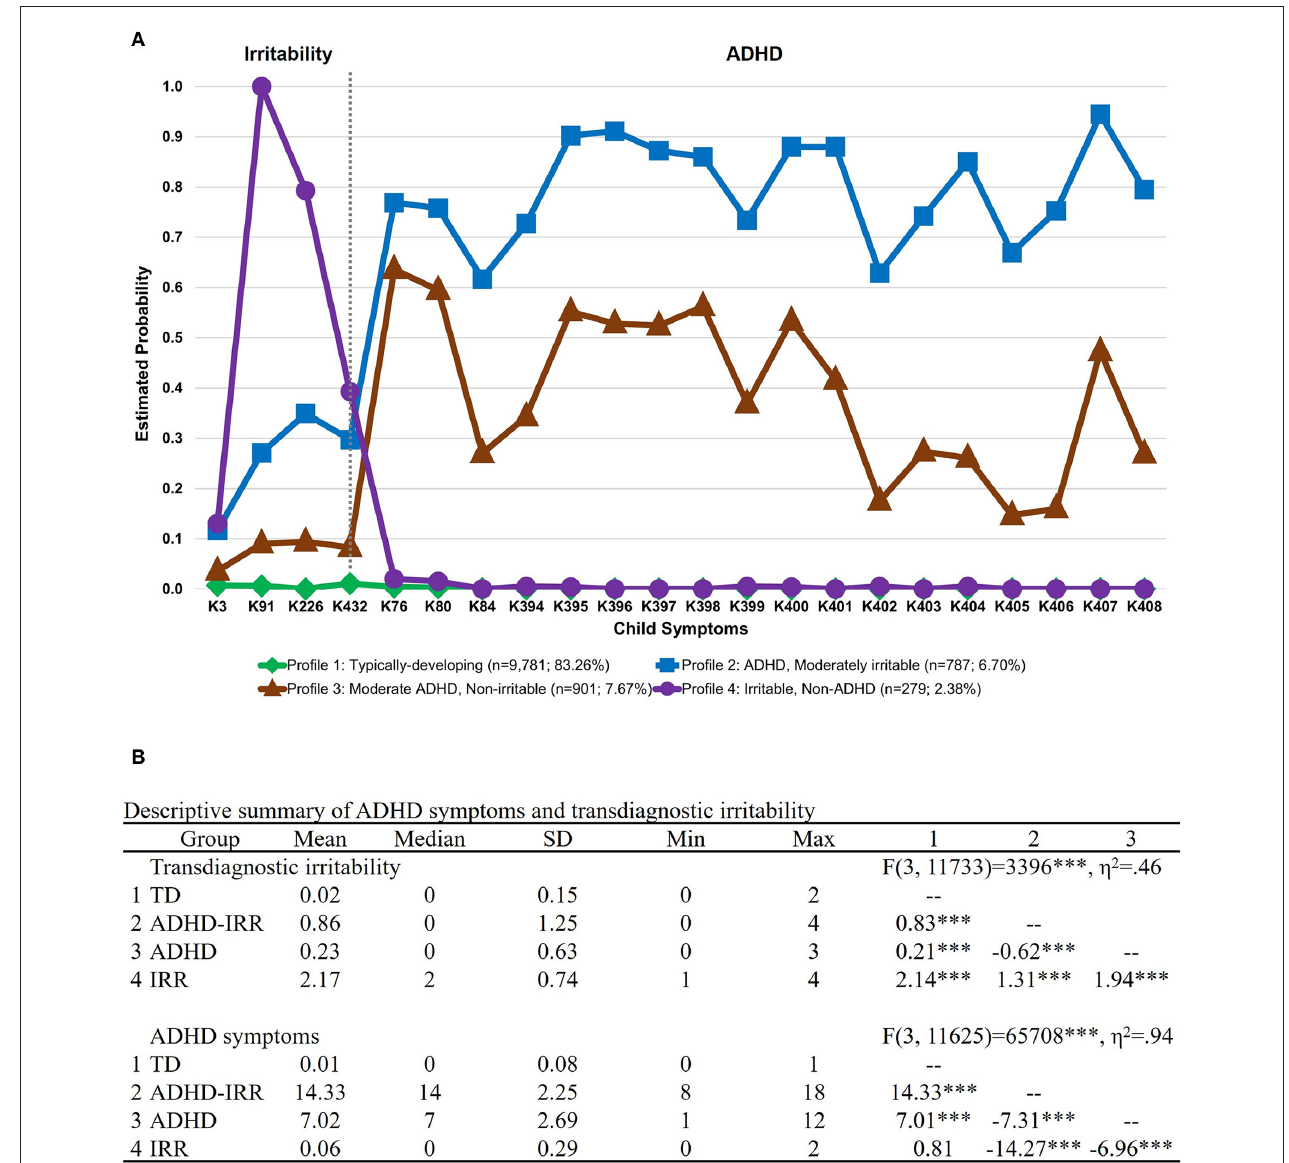
FIGURE 2 | Latent class membership based on ADHD symptoms and transdiagnostic irritability. Symptoms were derived from item-level symptoms assessed by the parent interview of the DSM-5 Kiddie Schedule for Affective Disorders and Schizophrenia (K-SADS). (A) Latent class graph visualizing the estimated probability of ADHD symptoms and transdiagnostic irritability for each group. (B) Descriptive summary of ADHD symptoms and transdiagnostic irritability for each latent class group based on item-level symptom count on the K-SADS. The numbered columns represent adjusted pairwise comparisons following the omnibus test of differences in symptom counts across groups. ADHD, attention-deficit/hyperactivity disorder; IRR, irritability; TD, typically developing. *** p <